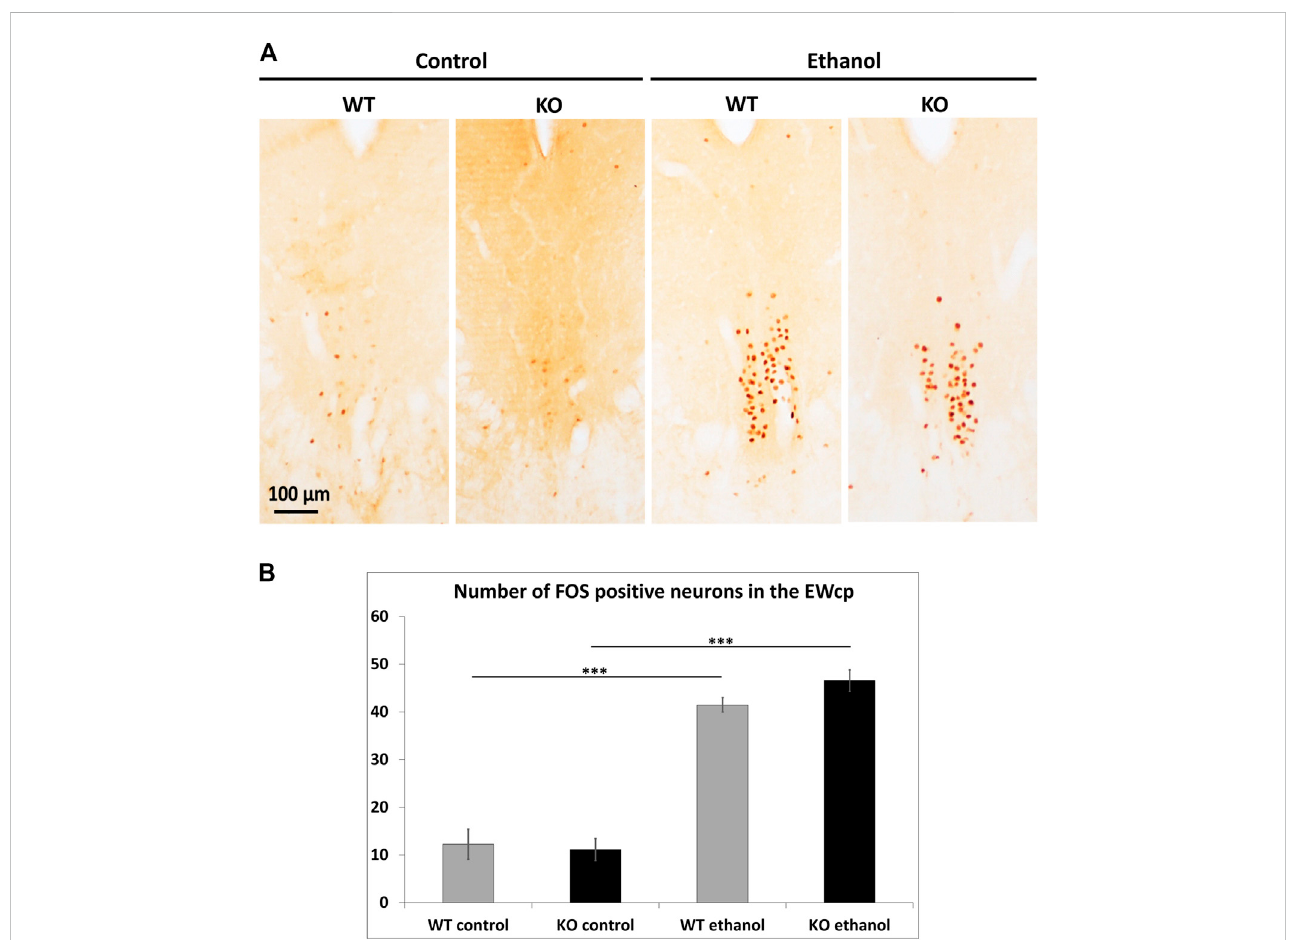
FIGURE 3 Quantitation of FOS immunoreactivity in the centrally projecting Edinger – Westphal nucleus (EWcp). (A) Representative immunohistochemical images showingtheexpression ofFOS,as amarkerofearlyneuralactivation,intheEWcp ofwildtype(WT) and Trpa1 knockout(KO) mice2 hafteri.p.,saline(control) and 1 g/kg ethanol injection. Neuronal activation is represented by brown colored nuclei. (B) Quantitative evaluation of FOS immunostaining in the EWcp of WT and Trpa1 KO mice, 2 hafter i.p., saline (control) and 1 g/kgethanol injection. Columns show means ± SEM of FOS positive neurons in the EWcp ( n = 6 – 8; *** p = .0001; Tukey ’ s post hoc test upon two-way